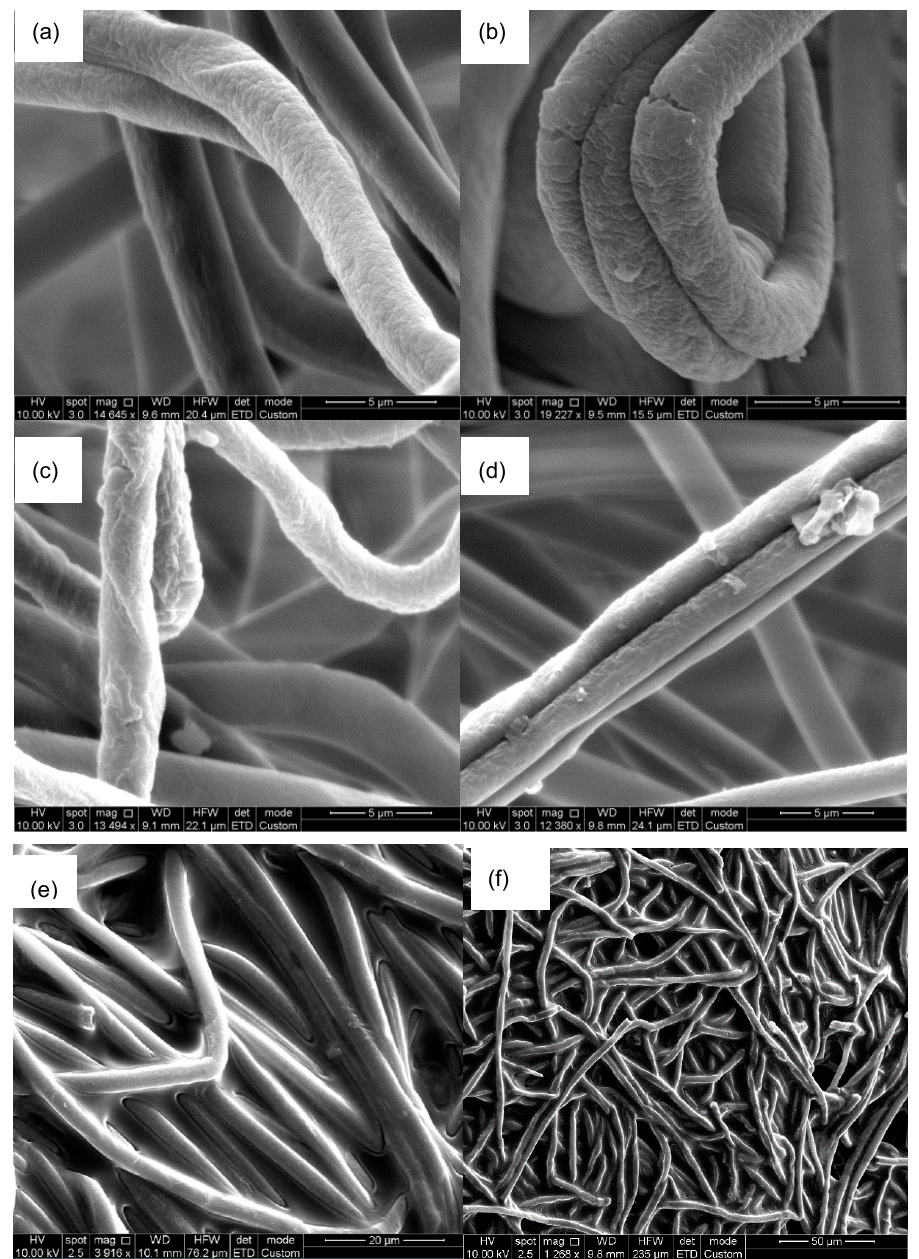
Figure 1. SEM images of ( a ) untreated, ( b ) 2 h acid-treated, ( c ) 10 h acid-treated, and ( d ) 24 h acid-treated nanofibers, ( e ) and ( f ) nanofibers with immobilized enzyme at 20 µ m and 50 µ m SEM